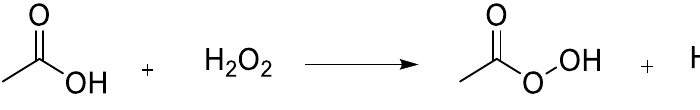
Scheme 3. Formation of peracetic acid .